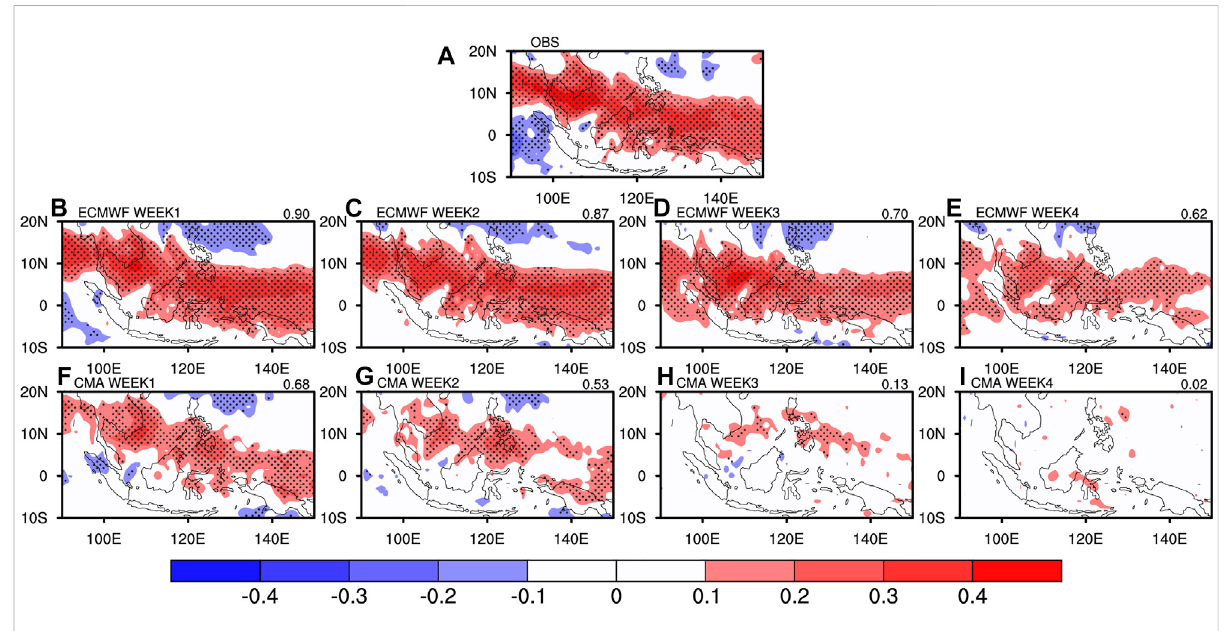
Spatial distribution of correlation coef fi cients between observed weekly mean precipitation anomalies and observed weekly mean OMI2 index (A) ,togetherwith thecorrelation coef fi cients mapsbetween forecasted weeklymeanprecipitationanomaliesand forecastedOMI2 indexinECMWF (B – E) and CMA (F – I) at the lead time of 1 – 4 weeks. The pattern correlation coef fi cients between observed correlation coef fi cients maps and forecasted correlation coef fi cients maps are also provided on the right strings. Stipples indicate correlations statistically signi fi cant at the 95%